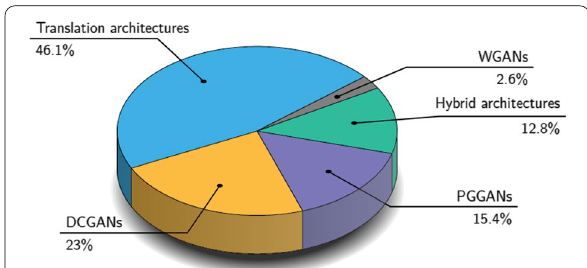
Fig. 7 The family of architectures proposed in the examined studies. WGANs, Wasserstein generative adversarial networks; PGGANs, progressive growing of generative adversarial networks; DCGANs, deep convolutional generative adversarial networks. Almost half of the examined studies employed translation architectures (i.e., pix2pix, cycleGAN, MUNIT) to translate from one MRI sequence to another or to incorporate different types of lesions into a healthy subject. The hybrid architectures consist of the combination of GANs and VAE to increase the stability of the training and to generate higher-quality synthetic images. The studies with the remained architectures focused on generating MRI images from a noise